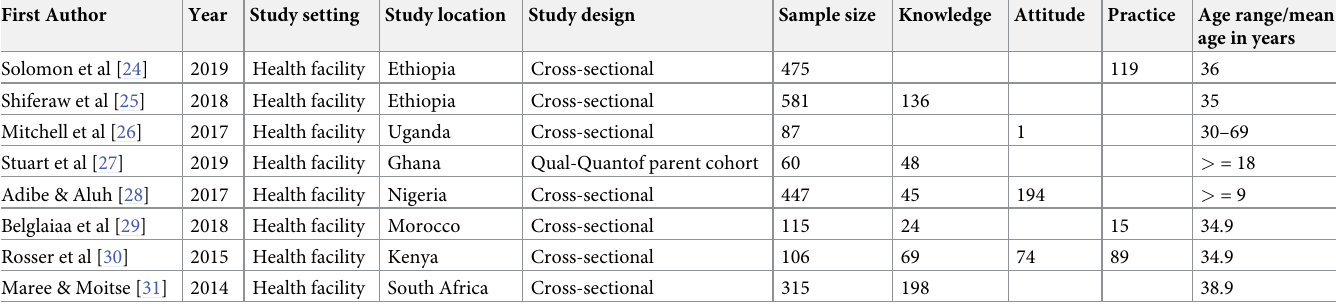
Table 1. Characteristics of included studies to estimate the pooled effect of knowledge, attitude and practice of HIV-infected women towards cervical cancer in